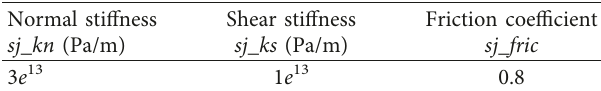
Table 4: Microscopic parameters of